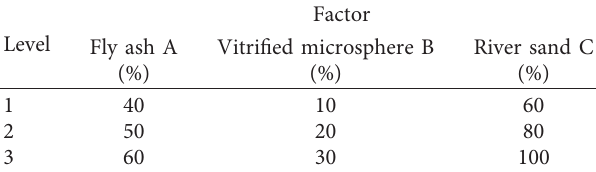
Table 2: Scheme of orthogonal experiment on the material ratio.